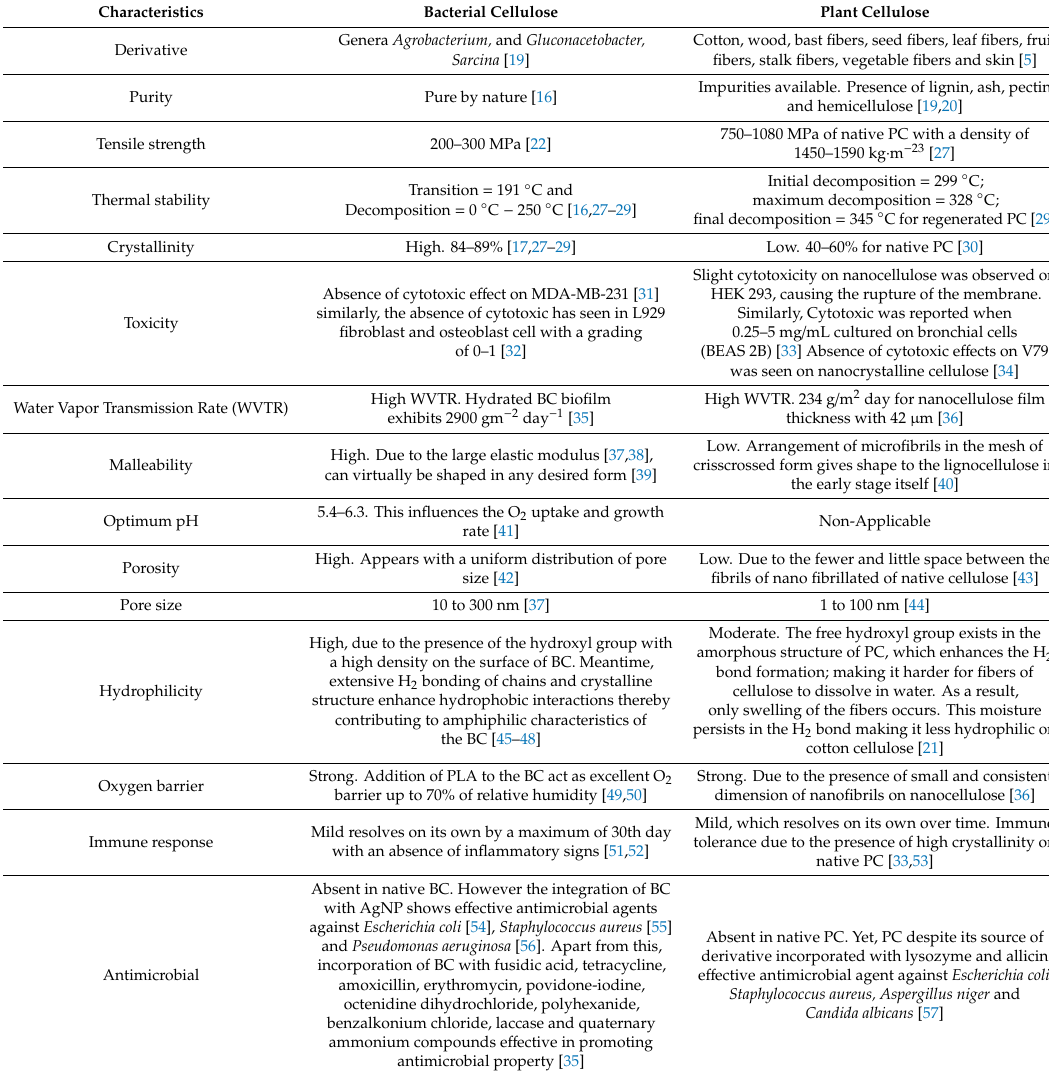
Table 1. Comparison of Plant and Bacterial